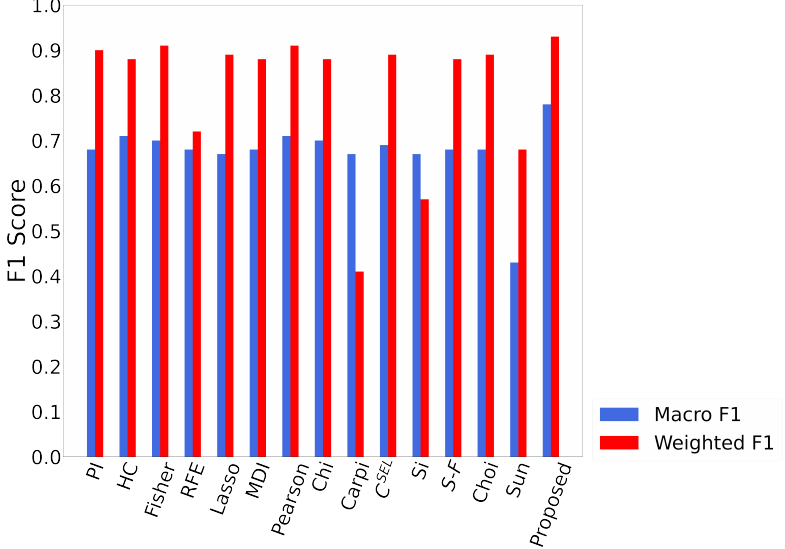
Figure 19. The performance of different sets of features in all APs LOS identification. Our proposed MSS is up to 28.8% better than popular feature selection models and up to 14.5% better than state-of- the-art WiFi LOS identification algorithms. Table 6. Comparison of the LOS identification performance of previous